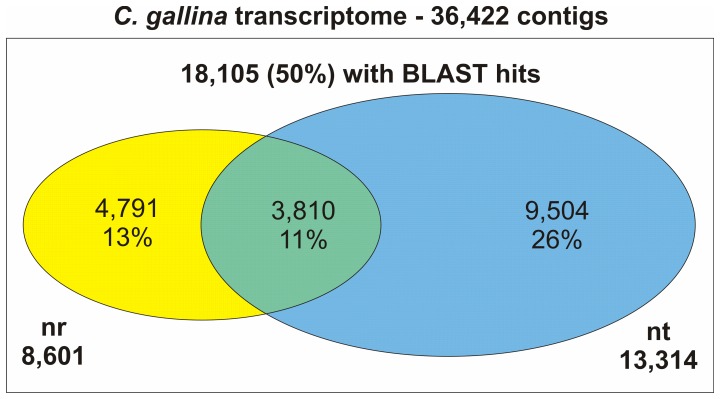
Set of annotated contigs of Chamelea gallina trascriptome with nucleotide and protein BLAST hits.The Venn diagram reports the intersection between number of contigs with BLAST hits in nr protein and nt nucleotide databases.